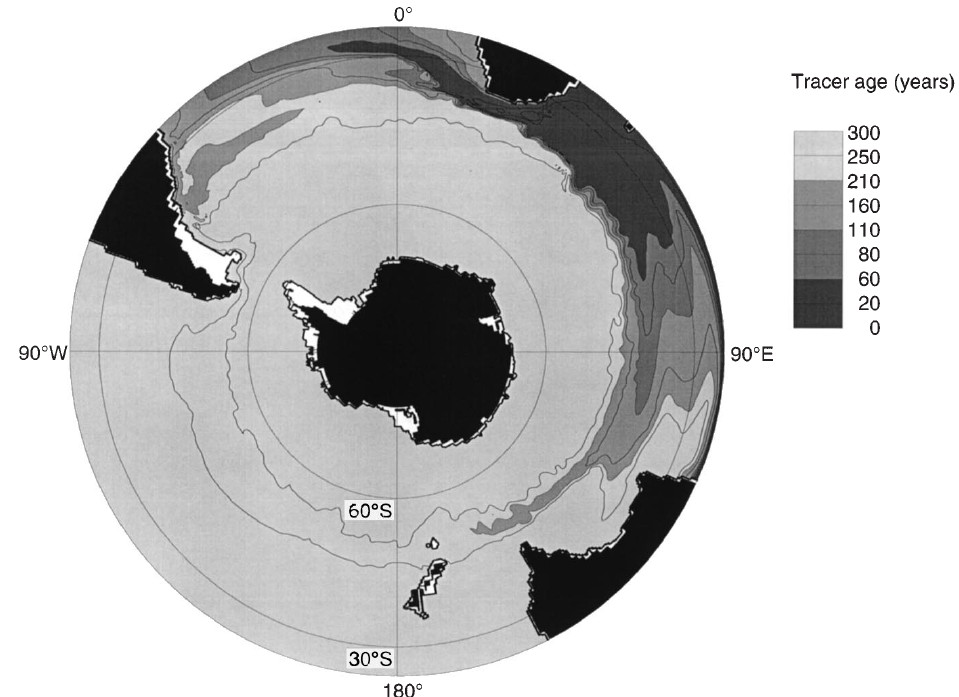
tracer introduced at the Indian Ocean boundary (24 (cid:14) S)